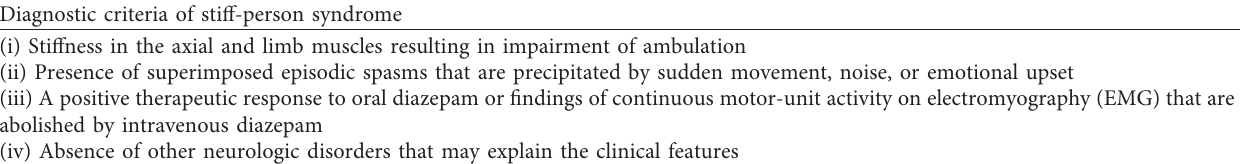
Table 1: Diagnostic criteria of stiff-person syndrome